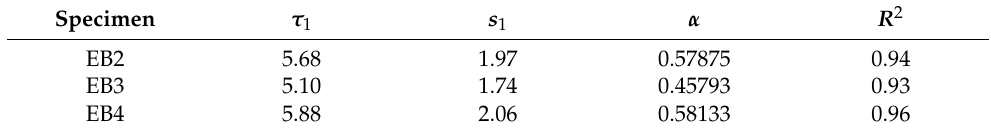
Figure 4. Bond–slip curve and calculation model. ( a ) EB2, ( b ) EB3, ( c ) EB4, and ( d ) bond–slip calculation model. Table 6. Curve constants and fitting coefficients of the specimen group.